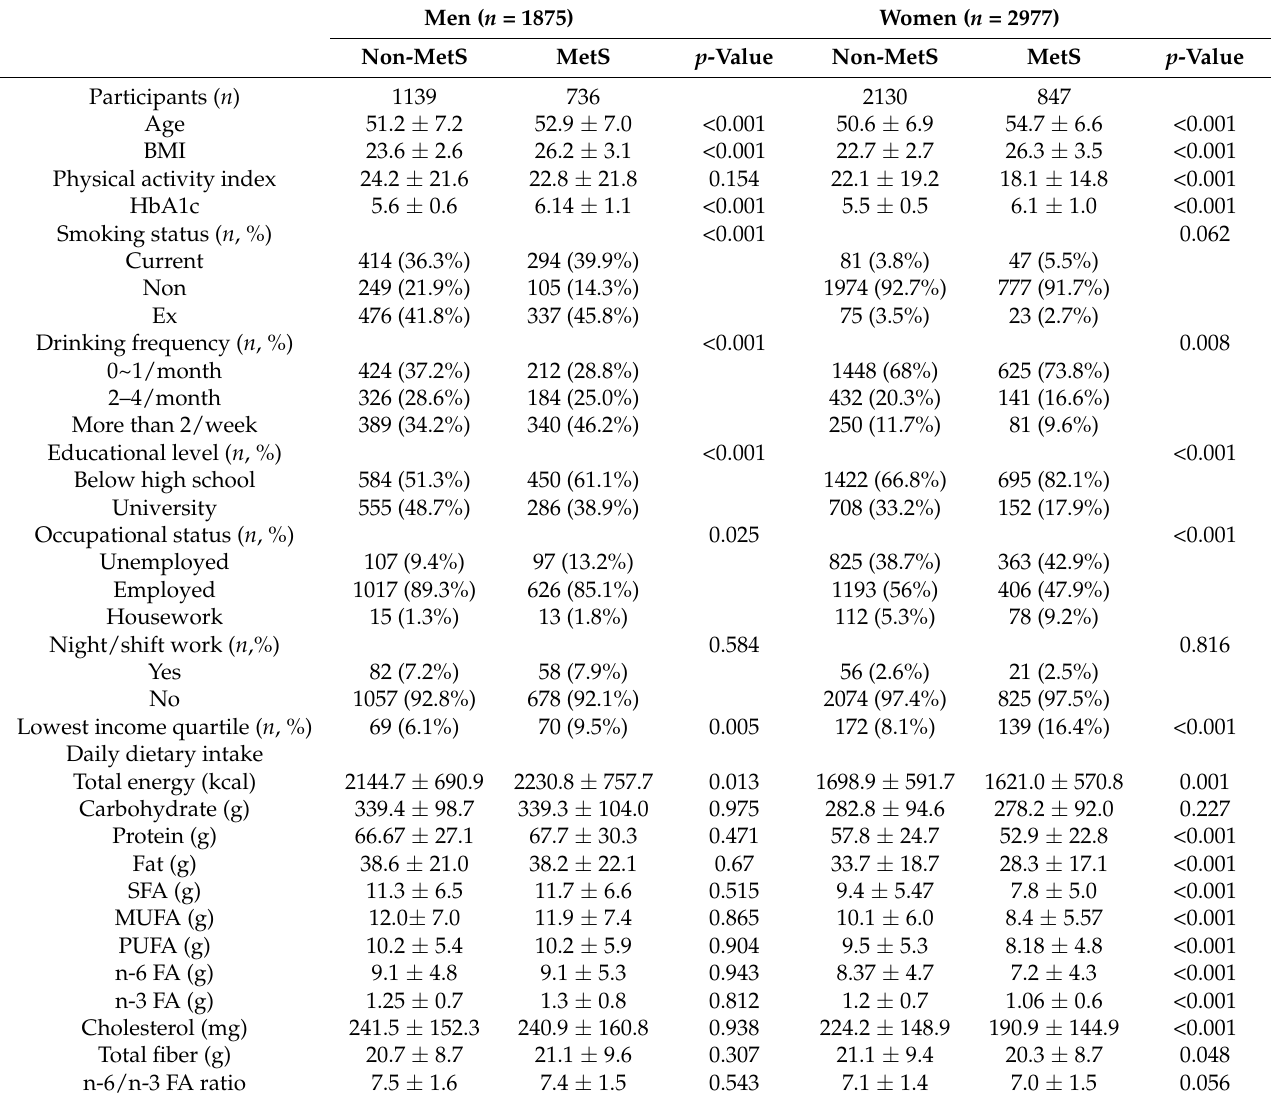
Table 1. Characteristics and dietary intakes of participants by gender and metabolic syndrome